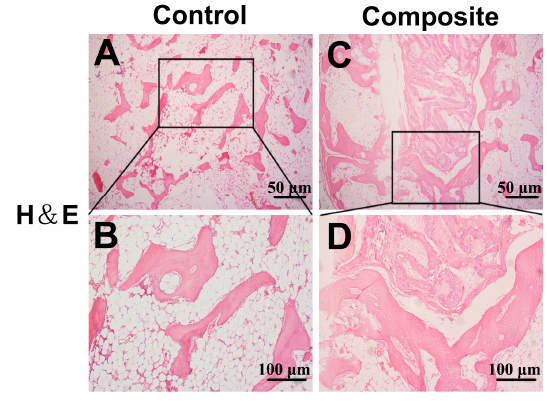
Figure 4. Cont. Figure 4.